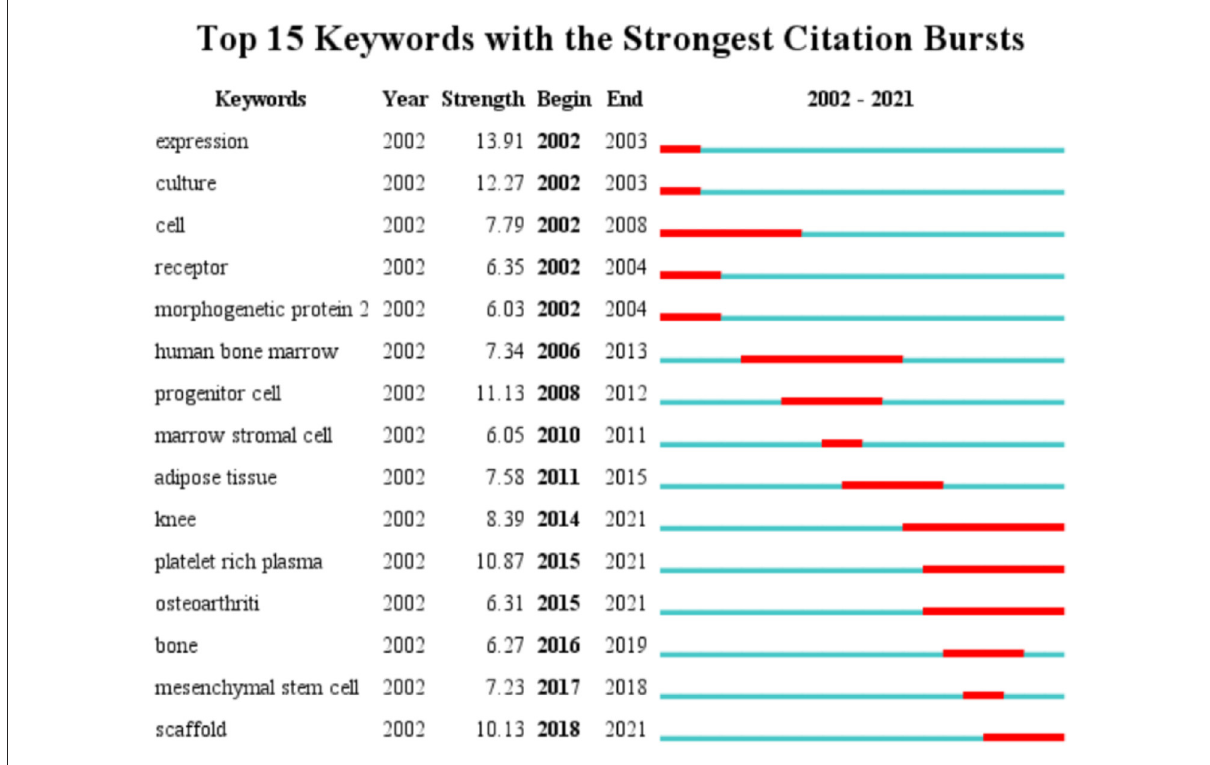
FIGURE9 The top 15 keywords with the strongest citation